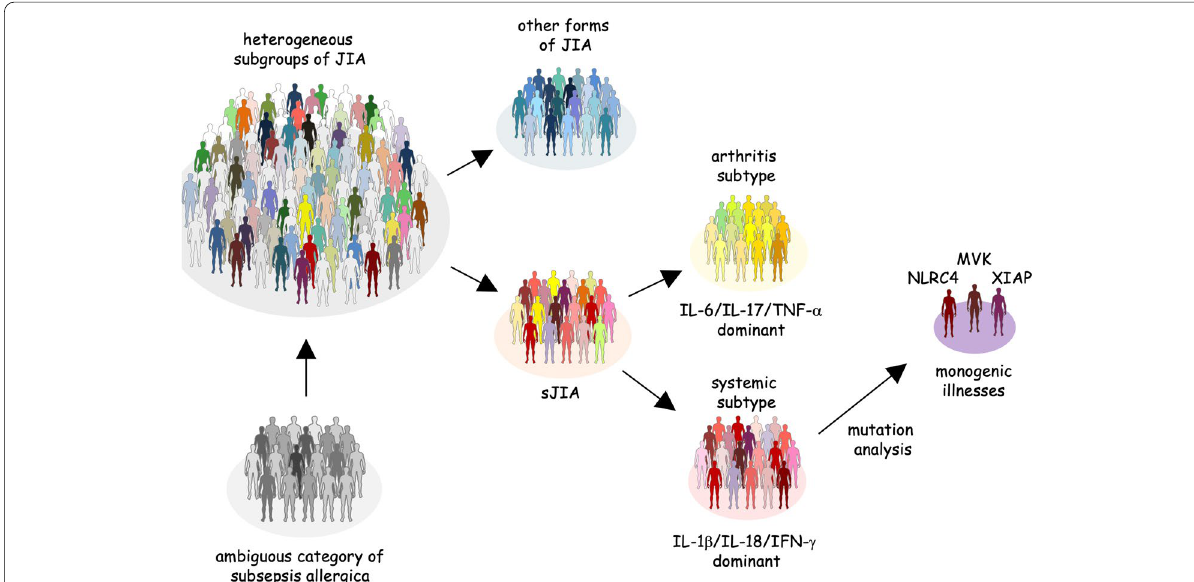
Fig. 6 Subgroups of JIA and subtypes of sJIA. Schematic presentation of subgroups of JIA and subtypes of sJIA. Previously, many cases of fever of unknown origin with systemic manifestation were diagnosed as “subsepsis allergica,” when sJIA was yet to be used to describe such